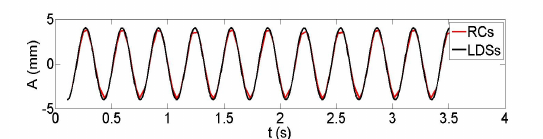
Figure 8. The estimated trajectories of the same thin plate centroid from the RC (30 Hz) and